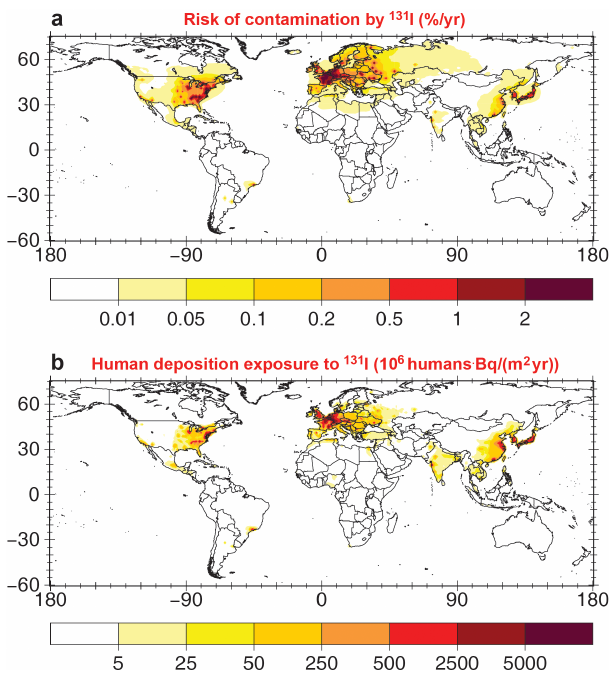
Fig. 4. Global risk of radioactive contamination by 131 I. (a) Mod- elled deposition of ≥ 40kBq 131 Im − 2 yr − 1 . The risk is the expected value normalized by 40kBqm − 2 . (b) Modelled risk of human ex- posure to 131 I